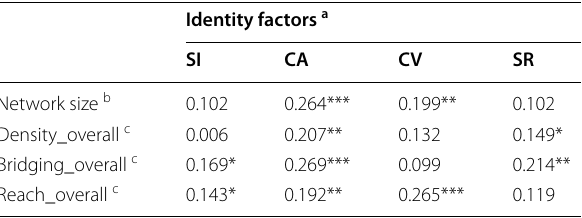
Table 3 Spearman’s correlations between teacher identity factors and CoP network variables